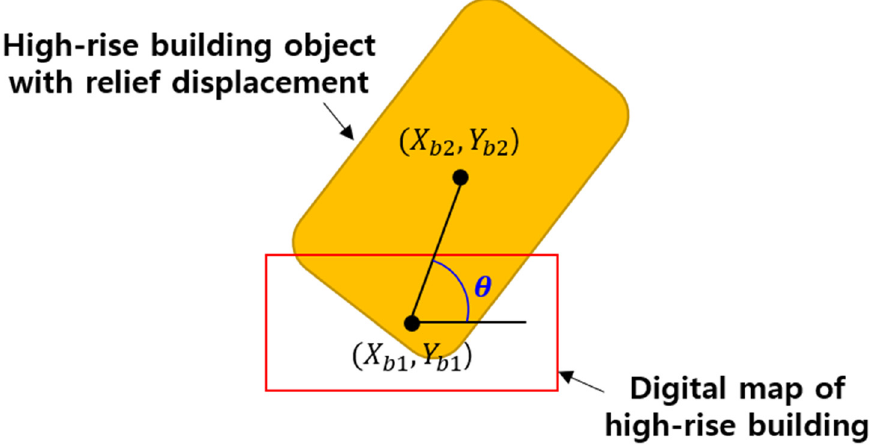
Figure 4. Calculation of the direction between a building and the digital map using its centroid coordinates.